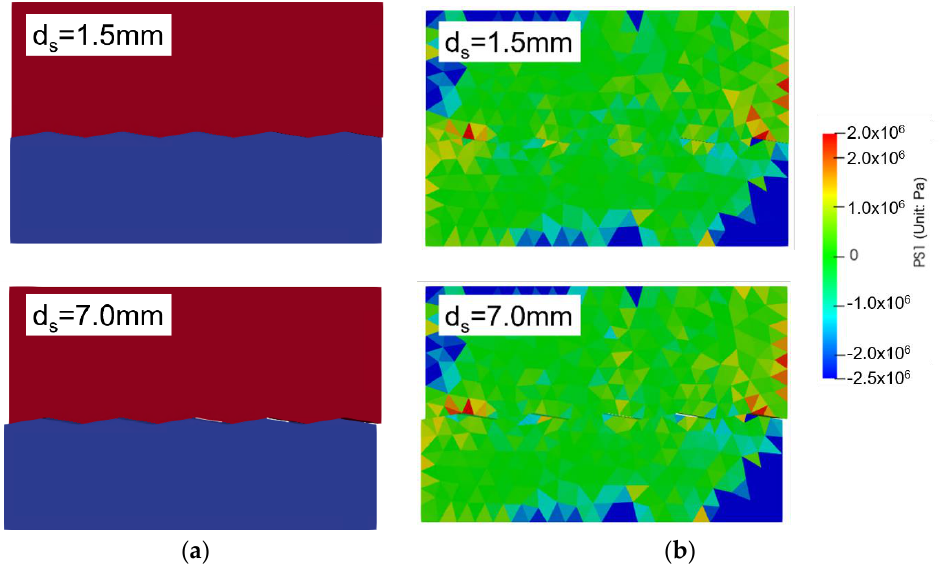
Figure 13. Simulation results in the shear test with a relatively smooth concrete–rock joint for the cases of asperity angles α = 10 degrees. ( a ) Macroscopic crack, ( b ) maximum principal stress distribution (PS1).